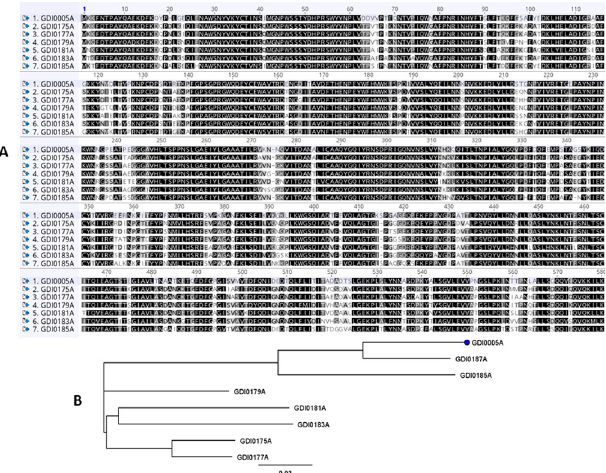
Fig 4. Protein alignment of GDI0005A homologs. (A) GDI0005A and homologous protein sequences were aligned using Geneious Multiple alignment tool with the Blosum 62 cost matrix. Identical amino acids are indicated in black; conserved amino acids in grey; all the others are in white. (B) Phylogenetic tree of GDI0005A homologs built with the Neighbor-joining method using the Jukes-Cantor Genetic Distance model (Geneious Tree Builder from Geneious).